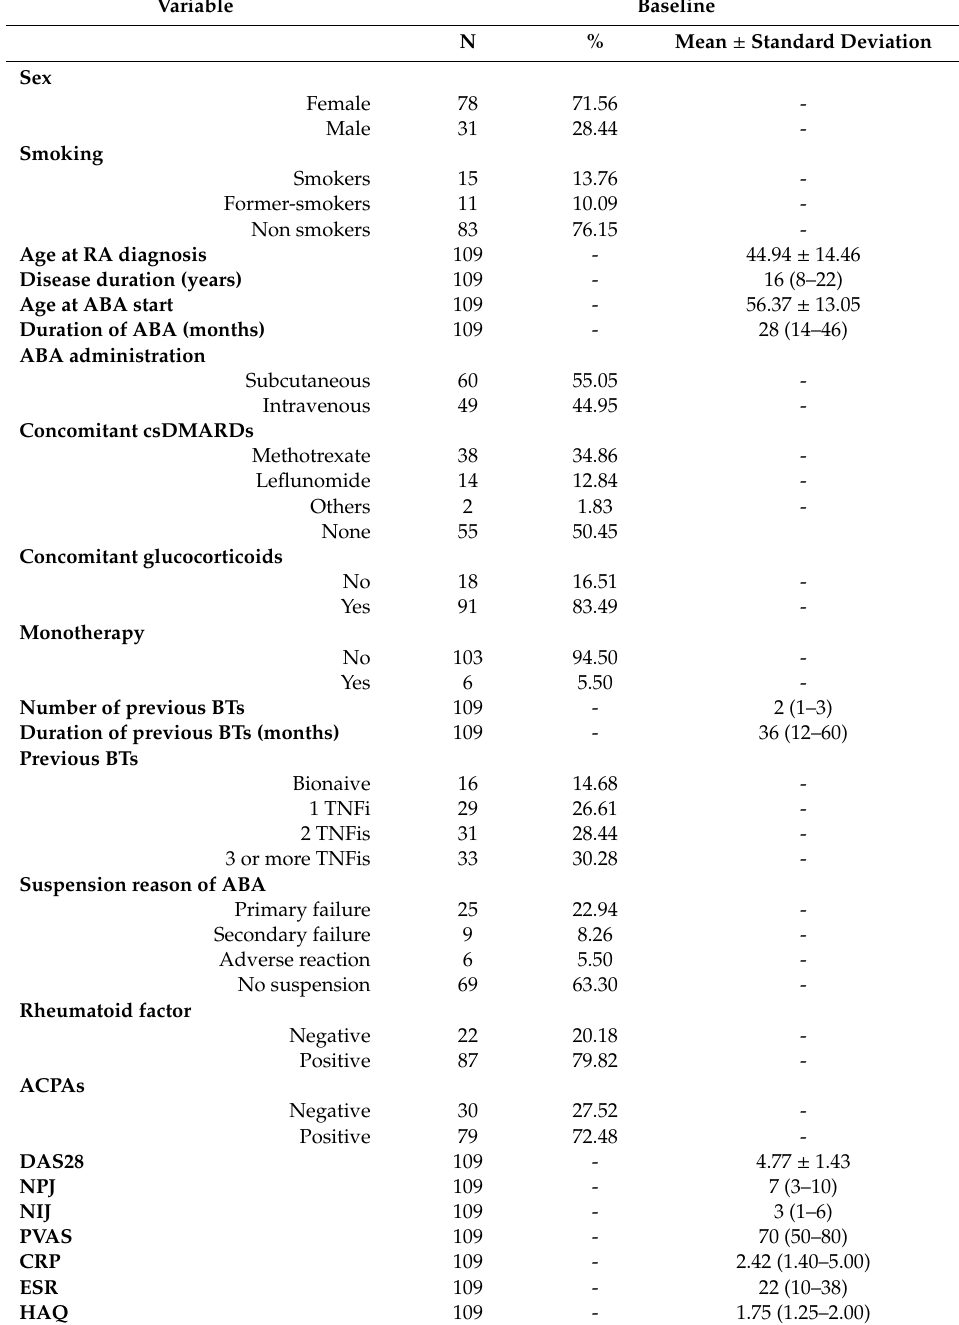
Table 1. Demographic and clinical characteristics of patients treated with